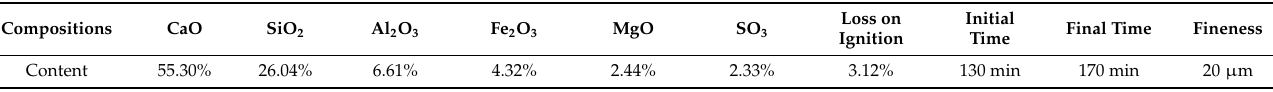
Table 2. Chemical and Physical Compositions of OPC.